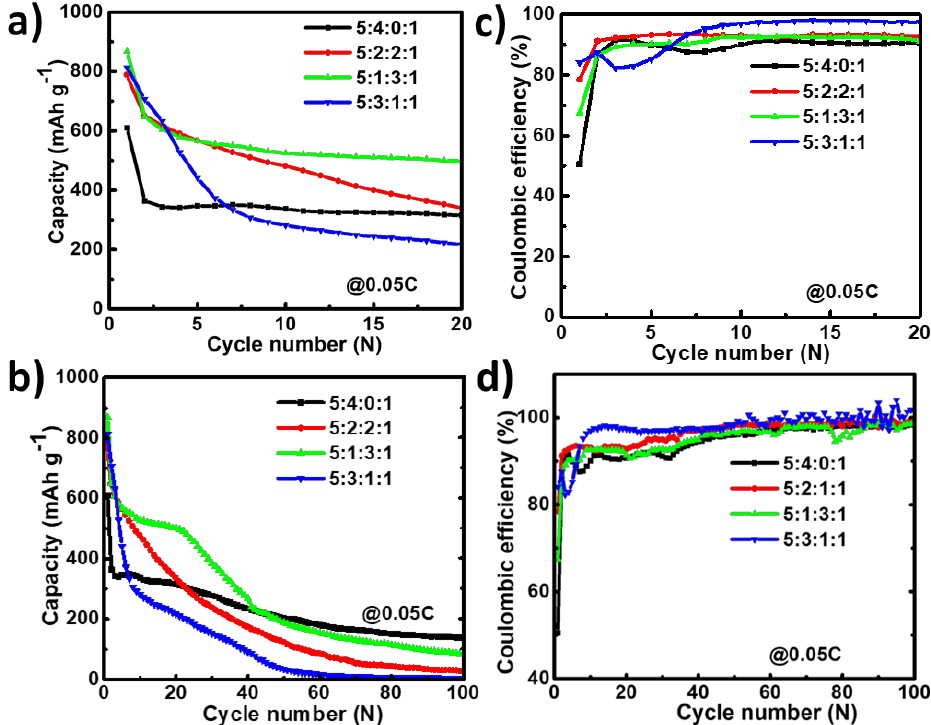
Figure 7. Effect of graphite on cyclic performance and coulombic efficiency of EGaInSn LMNP elec- trodes in the first 20 cycles ( a , b ) and over 100 cycles ( c , d ) at a current density of C/20 (0.05 C or 50 mA g –1 ). The cells were operated in a potential window of 0 to 1.5 V vs. Li/Li + .